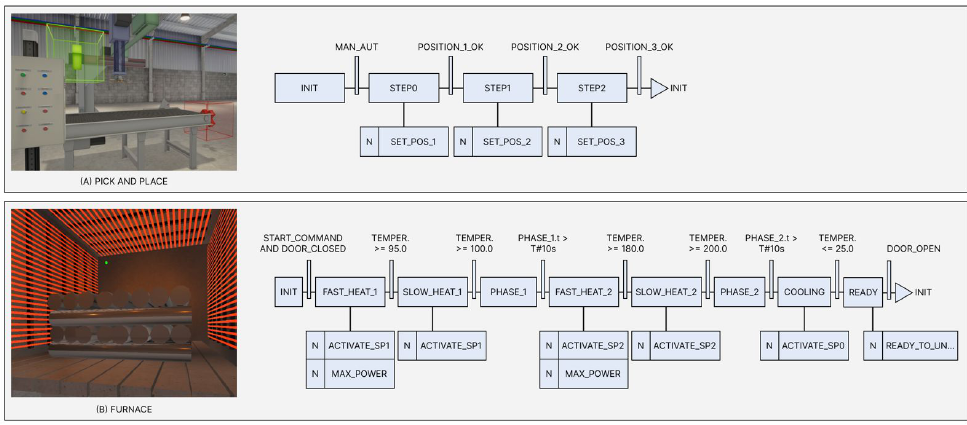
Figure 4. Machine simulators and their SFCs: ( A ) Pick And Place System, with X, Y, and Z movement axis; and ( B ) Furnace, with a heating